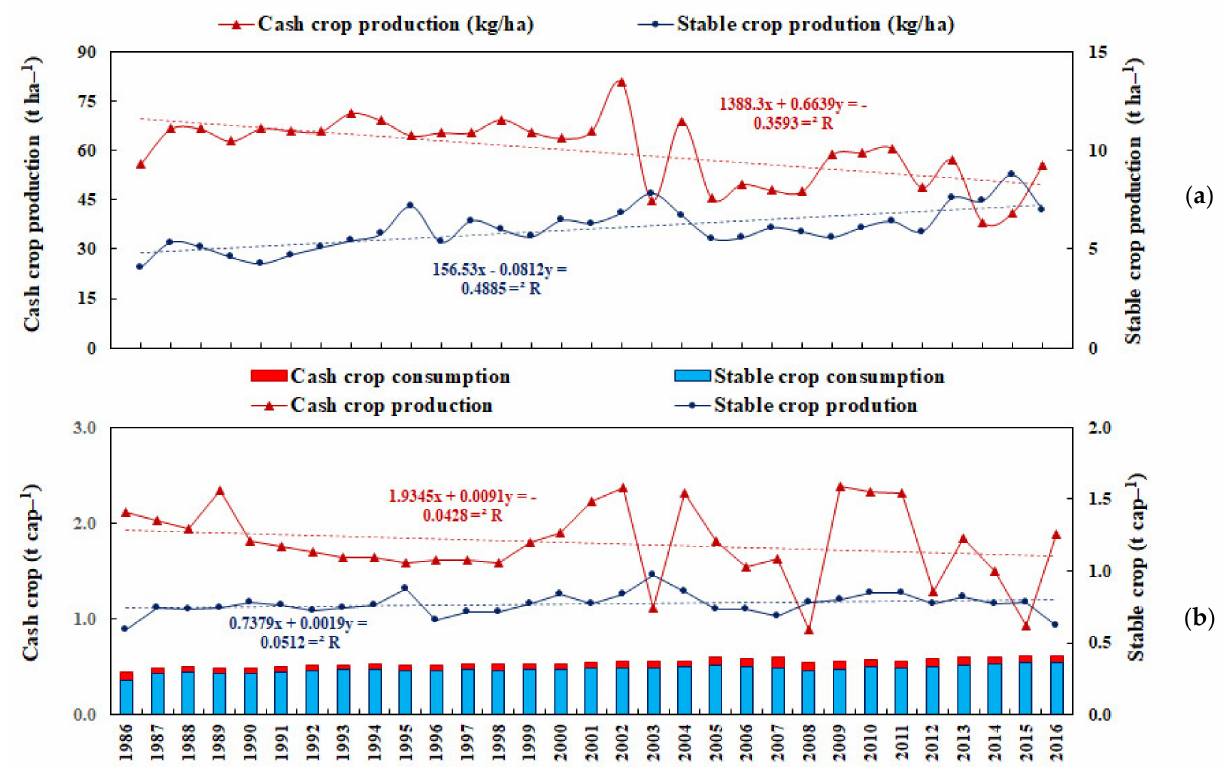
Figure 5. Evolution of cash/staple crop production per area (kg ha − 1 , ( a )) and per capita (kg cap − 1 , ( b )), and per capita staple/cash crop consumption ( b ) in the Khuzestan province over the